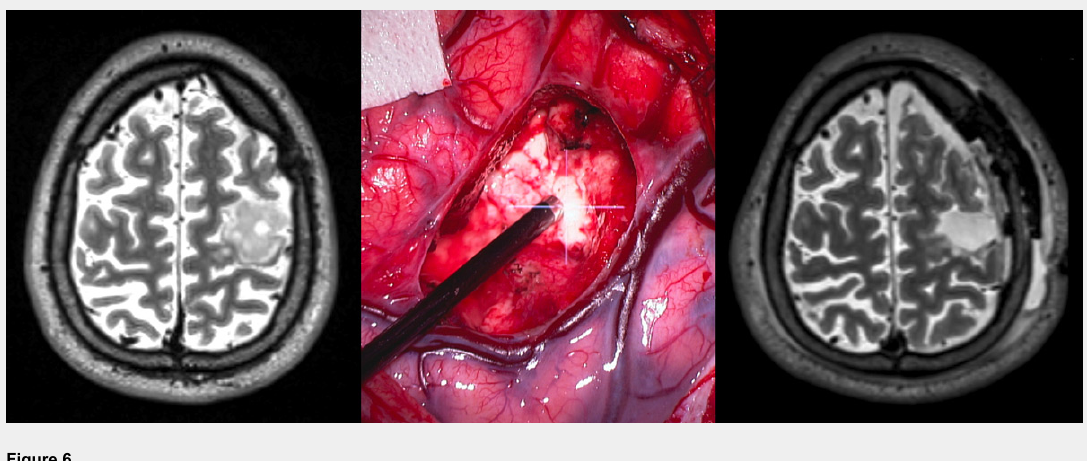
Figure 6 Example of a surgery for a lesion adjacent to eloquent tissue lesion. Left: Preoperative imaging reveals a glioma within the primary motor cortex. Middle: intraoperative continuous motor mapping guides surgery in proximity to the corticospinal tract. Right: postoperative imaging depicts gross total resection.